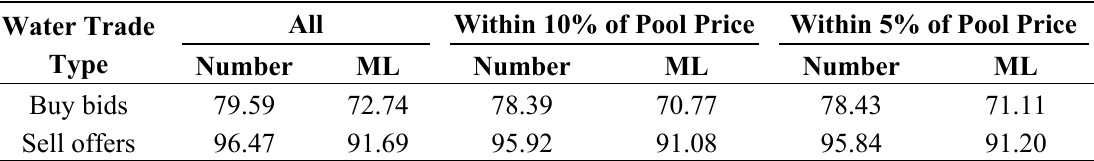
Table 2. Water allocation price clustering (%) at whole